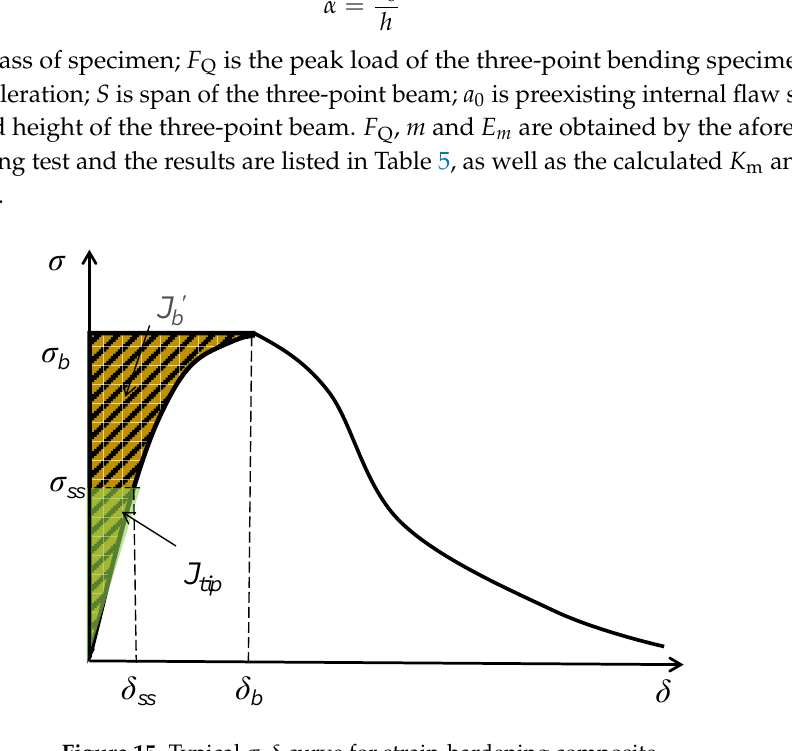
Figure 15. Typical σ – δ curve for strain-hardening composite. Table 5. Fracture toughness of